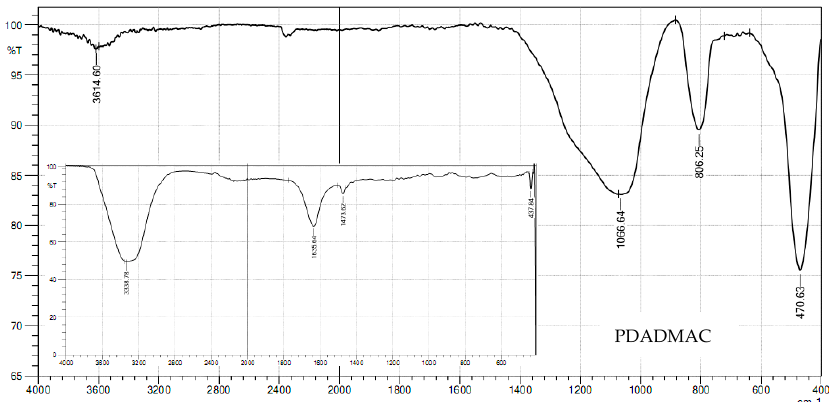
Figure 10. FTIR spectrum of nanosilica particles after PDADMAC adsorption in the wave number range of 400–4000 cm –1 . The inset is an FTIR spectrum of PDADMAC solution.